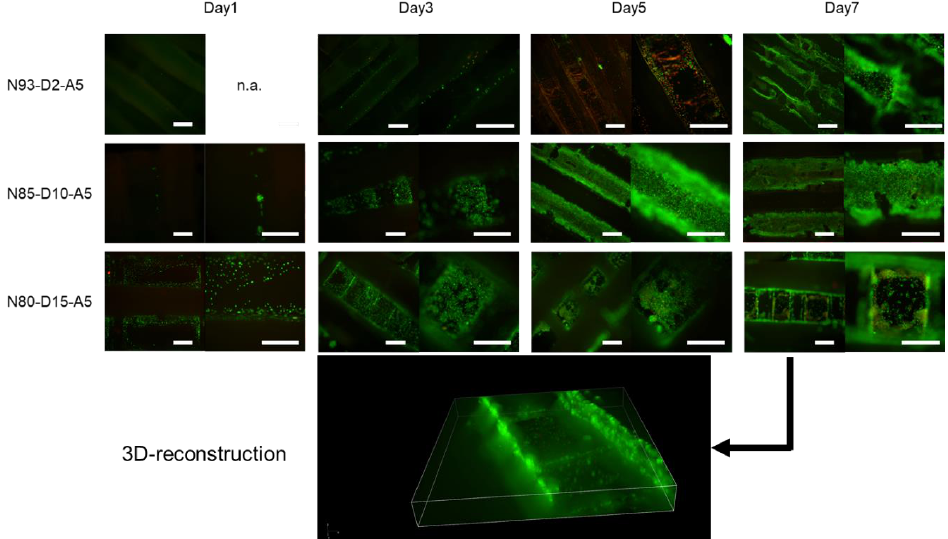
Figure 9. Fluorescence micrographs of three-dimensional lattice-type scaffolds seeded with L929 fibroblasts (2, 10, and 15% w / w DMAEA, 5% w / w AMO, 3% TMPTA, 10 s/layer, 4% w / w PI) and cultivated with periodic temperature changes at different time points (1, 3, 5, and 7 days). Scale bars equal 500 µm (low magnification (4×), left images) or 200 µm (higher magnification (10×), right images). Three-dimensional reconstruction of fluorescent images of N80-D15-A5 at 7 days.